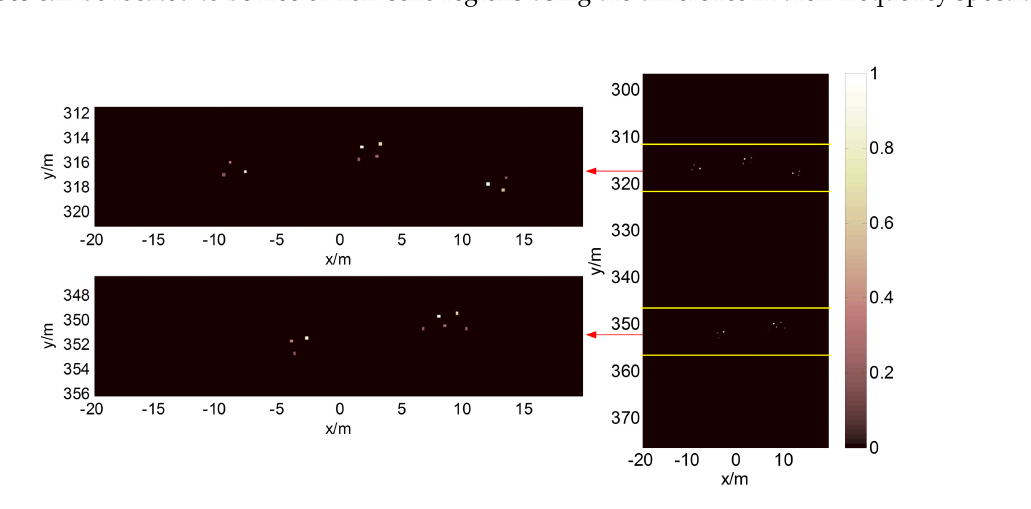
Figure 6. Target model in the simulation. The dynamic range is